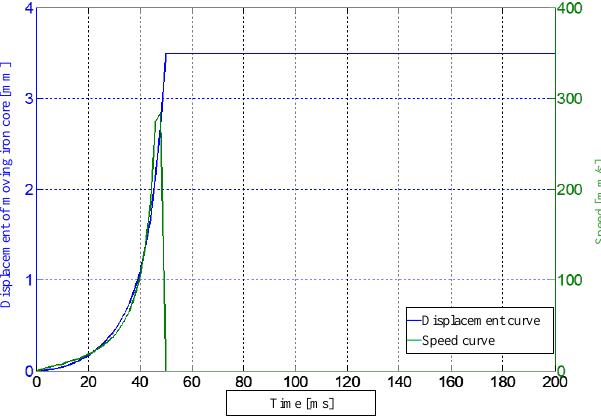
Figure 16. Mobile dynamic core displacement and velocity curve.